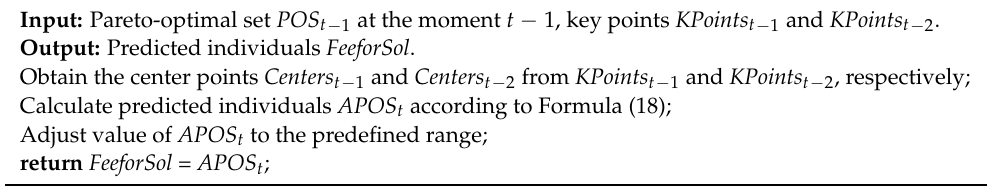
Algorithm 5: Center-point-based feed-forward prediction (CPFF)